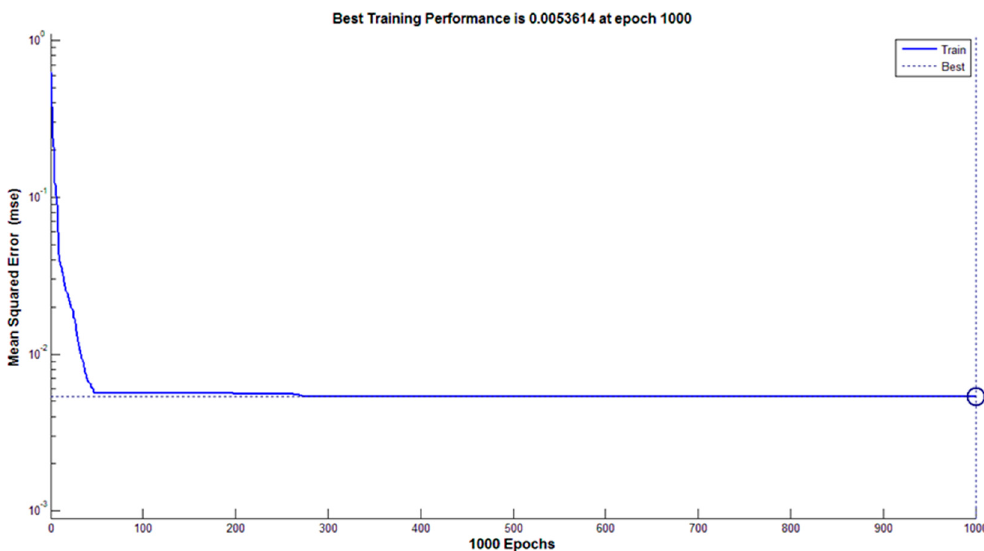
Figure 19. The curve of how to train a designed neural network to identify and classify. Paddy cultivars.